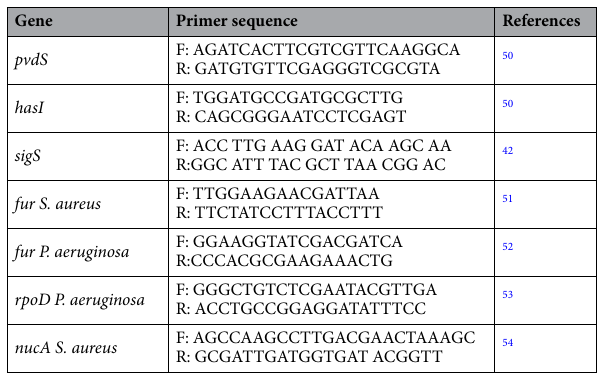
Table 4. List of